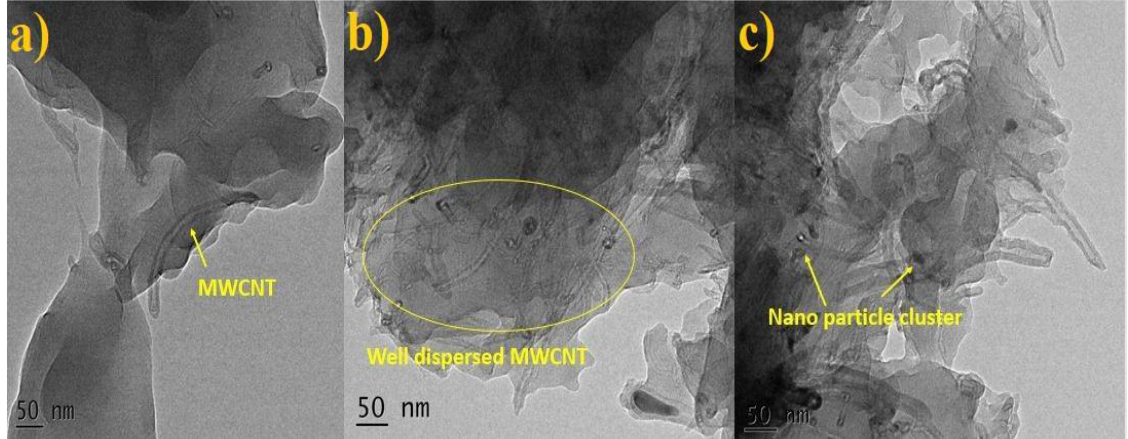
Figure 3. TEM images corresponding to ( a ) E-C0.5 ( b ) E-C1 ( c ) E-C1.5.